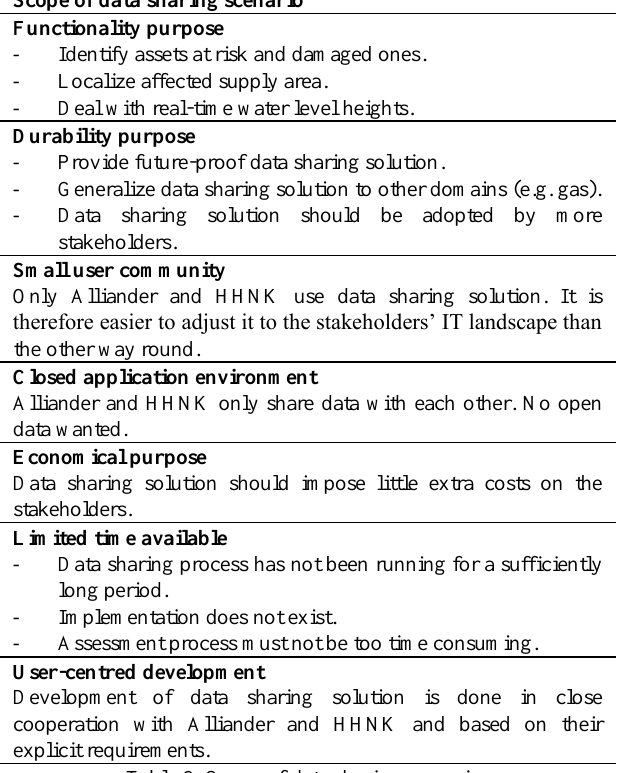
Table 2. Scope of data sharing scenario